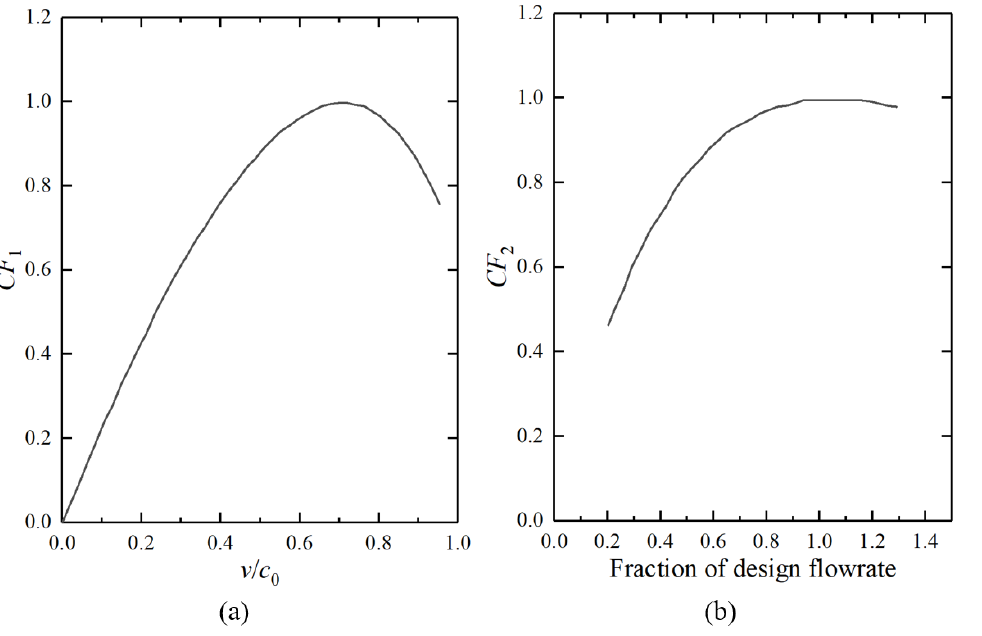
Figure 4. Influencing factors of expander isentropic efficiency. ( a ) Relationship between CF 1 and v / c 0 . ( b ) Relationship between CF 2 and fraction of design flowrate .